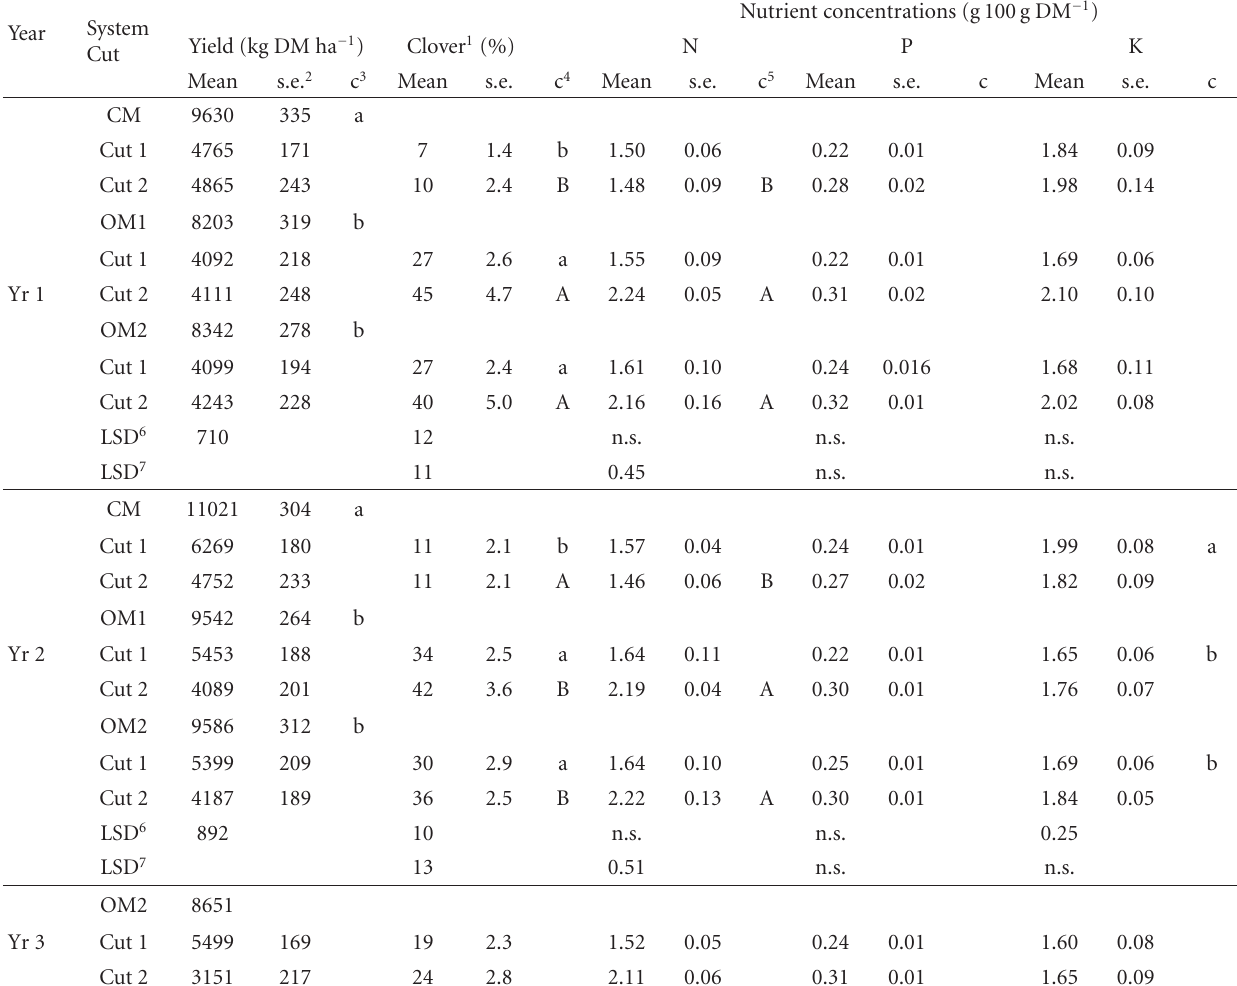
Table 4: Harvested ley yields, clover contentand concentrations of N, P, and